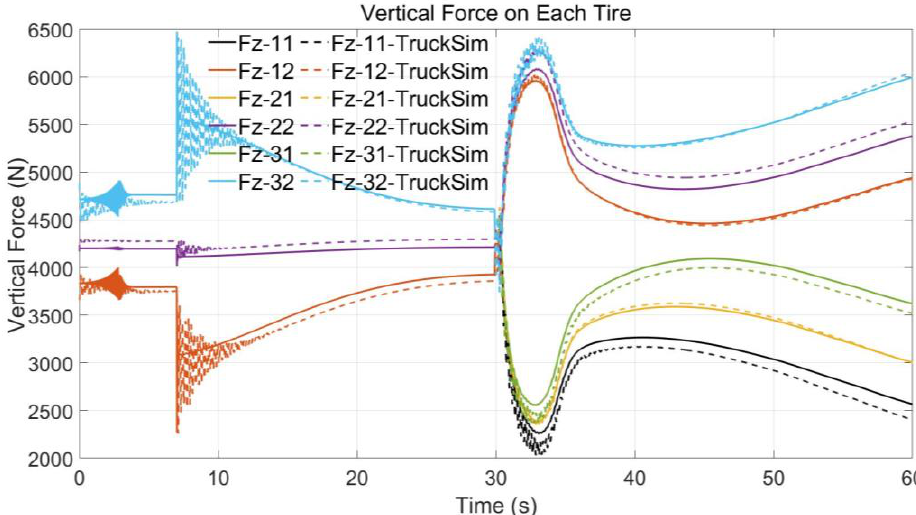
Figure 6. Vertical force calculation compared with TruckSim simulation.